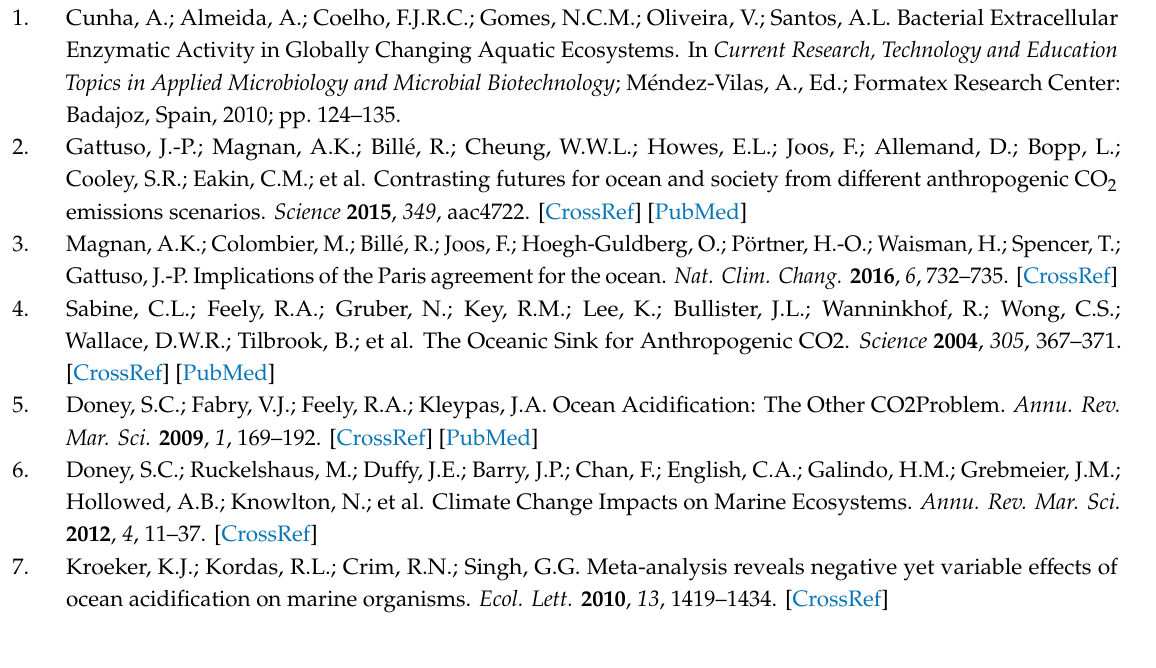
Figure S1: Nutrient measure in microcosm during 5 days of incubation. (A) NO 3 (B) NO 2 (C) PO 43 − . Black circle represents oceanic water from station T5, Gray circle represents the control treatment, Blue circle represented high pH / low p CO2, Red circle represents treatment under low pH / high p CO2. Figure S2: Characterization of the environmental variables in microcosm. (A) pH (B) p CO 2 (C) Cellular abundance. Black circle represents oceanic water from station T5, Gray circle represents the control treatment, Blue circle represented high pH / low p CO 2 , Red circle represents treatment under low pH / high p CO 2 . Figure S3: Cluster diagram of relative abundance of the most abundant taxa (above 1% in at least one sampling point in microcosm) assigned to bacterial phylogenetic groups obtained from station T5, Control, microcosms high pH / low p CO 2 and microcosms under low pH / high p CO 2 in two fraction size (A) Free-living and (B) Particle attached, n = 3. Table S1: BIO-ENV results show the combination of variables that best explain the particle attached bacterial community pattern. The left column contains the variables considered in the analysis and the right column contains the Spearman correlation coe ffi cient (Rho). Table S2: BIO-ENV results show the combination of variables that best explain the free-living bacterial community pattern. The left column contains the variables considered in the analysis and the right column contains the Spearman correlation coe ffi cient